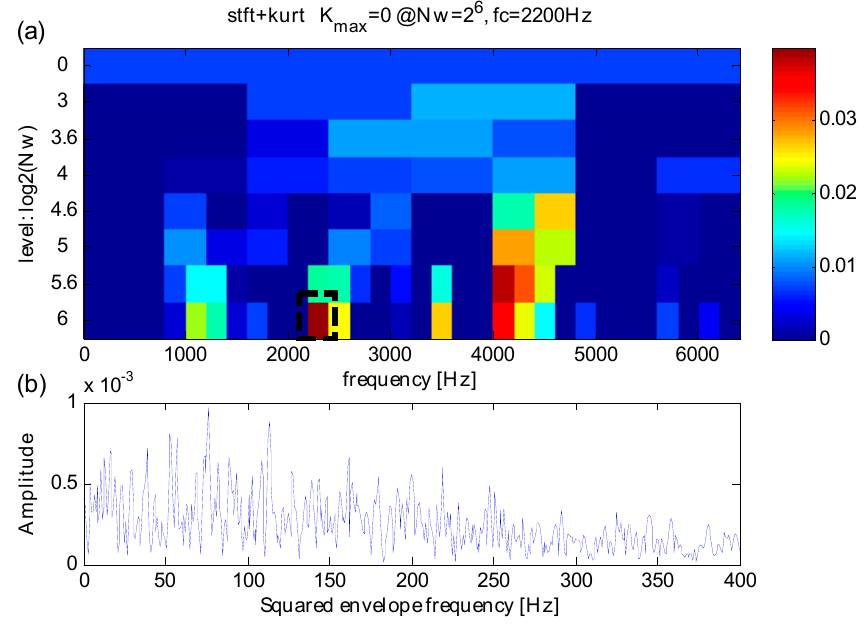
Figure 7. ( a ) The results of original kurtogram; ( b ) the reuslts of squared envelope spectrum.